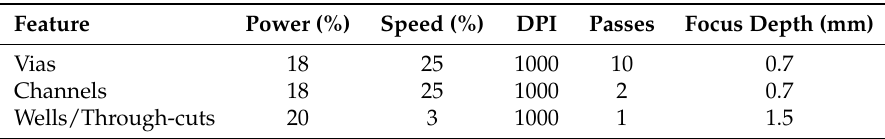
Table 1. Laser settings for various types of patterning.